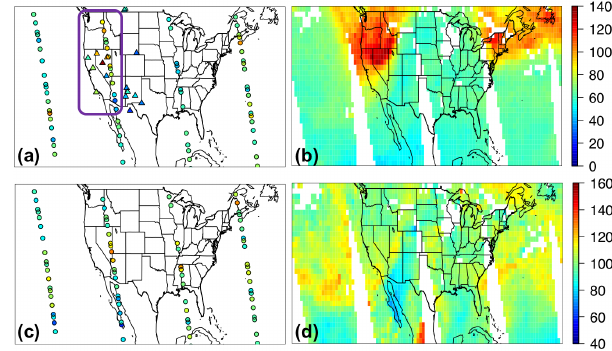
Figure 16. Same as Fig. 13, but for a case study of 10 June 2010.